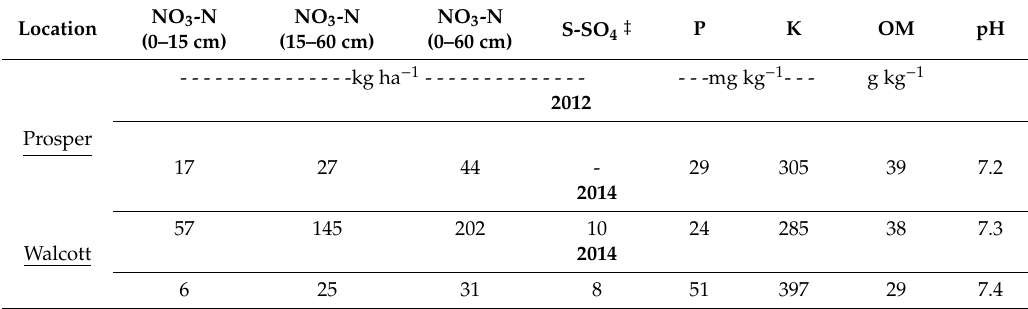
Table 2. Soil test results at the experimental sites in Prosper and Walcott, ND, USA in 2012 and 2014.